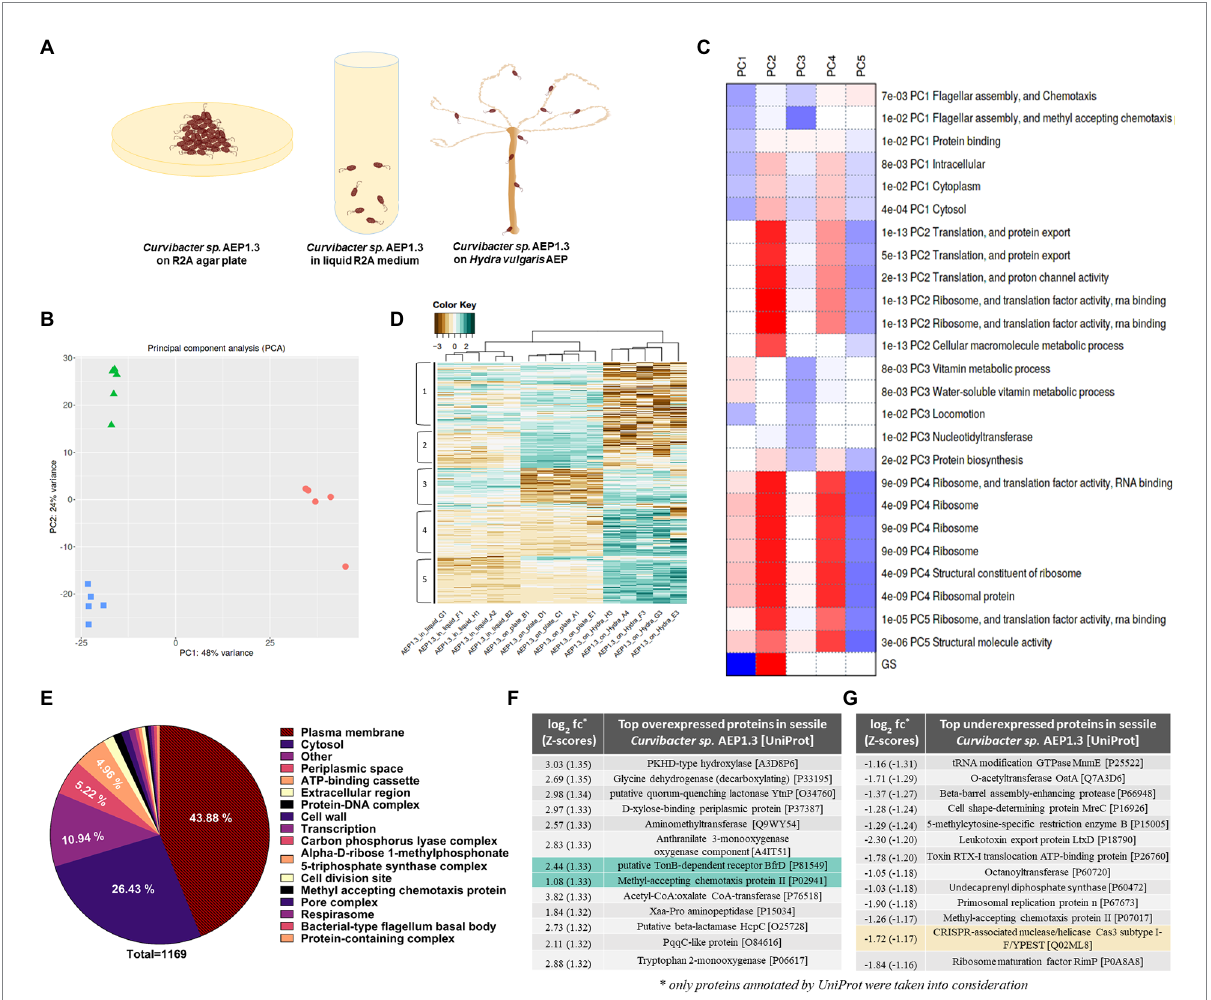
FIGURE 5 (A) Hypothetical model of sessile Curvibacter sp. AEP1.3 on solid R2A agar (left), planktonic Curvibacter sp. AEP1.3 in liquid R2A medium (middle) and Curvibacter sp. AEP1.3 on their host Hydra vulgaris AEP (right). (B) Principal component analysis comparing RNA sequencing results of Curvibacter sp. AEP1.3 on solid medium, liquid medium, and on Hydra n = 5. (C) Table showing factors contributing to principal components 1–5, based on molecular function. (D) Clustered heatmap based on log 2 + 1 transformed Z-scores to visualize differences in expression patterns between sessile, planktonic, and host-associated Curvibacter sp. AEP1.3 with scores ranging from − 3 to 2. (E) Pie diagram showing the percentage of proteins differentially expressed in Curvibacter sp. AEP1.3 on solid medium in comparison to planktonic and host-associated bacteria. Proteins were classified using the UniProt database. (F) Top proteins upregulated in sessile Curvibacter sp. AEP1.3 in comparison to planktonic and host- associated Curvibacter, sorted by Z-scores of log 2 fold changes. Green highlights indicate potential candidates for PCA1 phage binding. (G) Top proteins downregulated in sessile Curvibacter sp. AEP1.3, sorted by Z-scores of log 2 fold changes. Yellow highlights indicate potential candidates for defense against PCA1 phage